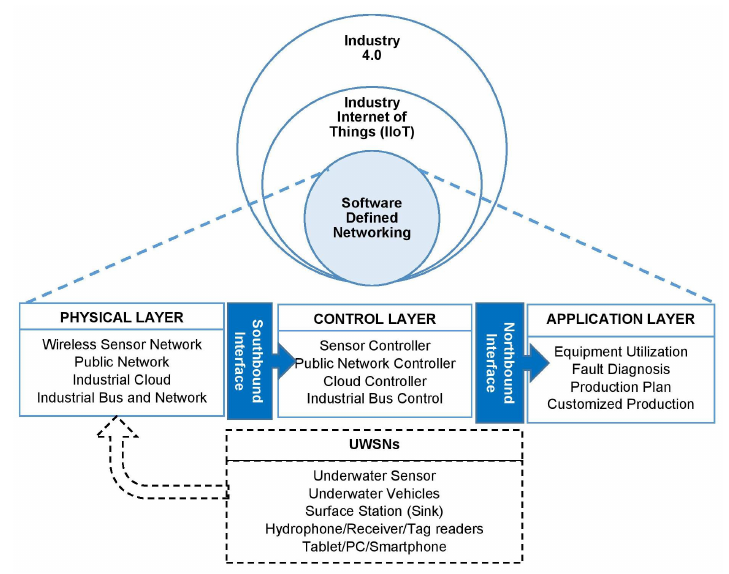
Figure 6. Relationship of SDN, IIoT, IoUT and Industry